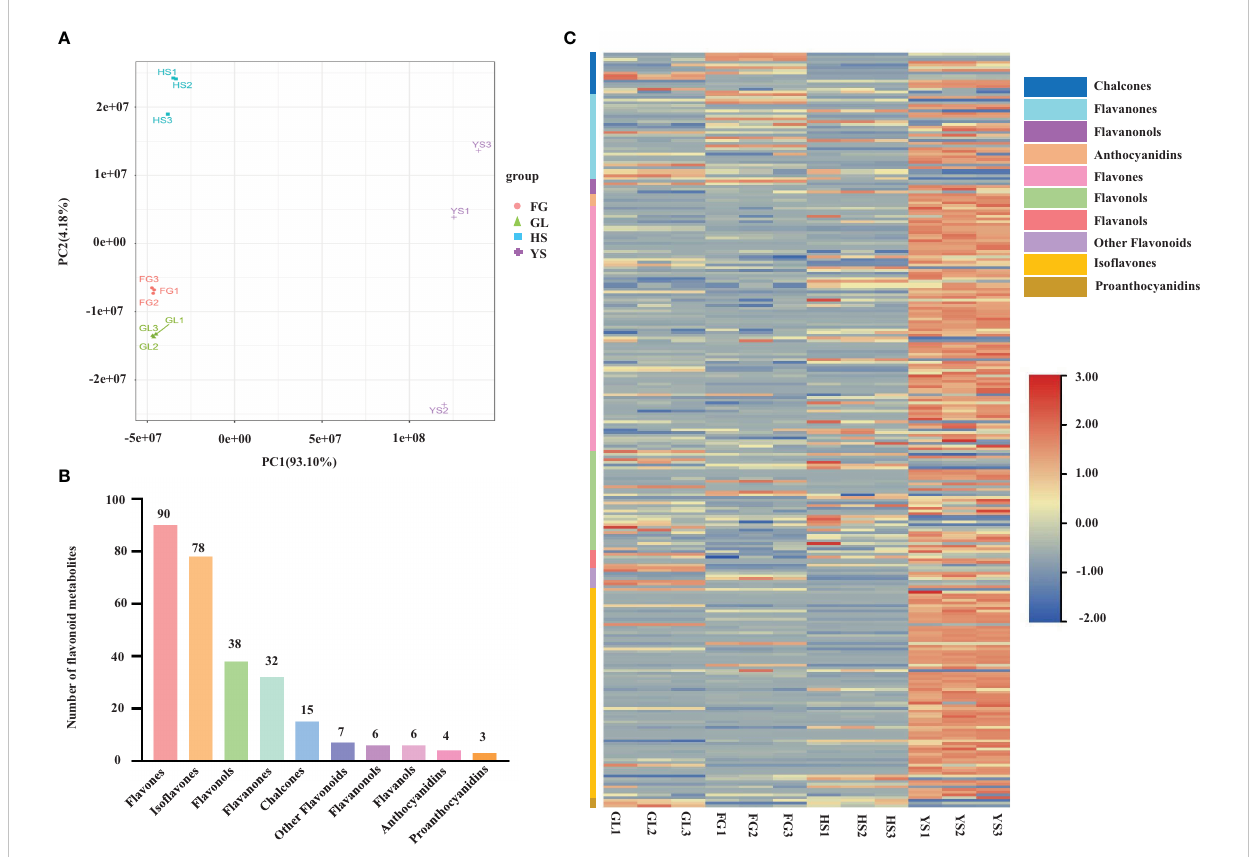
FIGURE 1 Principal component analysis and metabolite pro fi les of P. thomsonii and P. lobata . (A) PCA of all samples. (B) Classi fi cation and quanti fi cation of all detected metabolites. (C) Heatmap of fl avonoid metabolites in P. thomsonii and P. lobata . HS, P. thomsonii variety [Heshui (HS)]; FG, P. thomsonii variety [Fogang (FG)]; GL, P. thomsonii variety [Guilin (GL)]; YS, P. lobata variety [Zhangjiajie